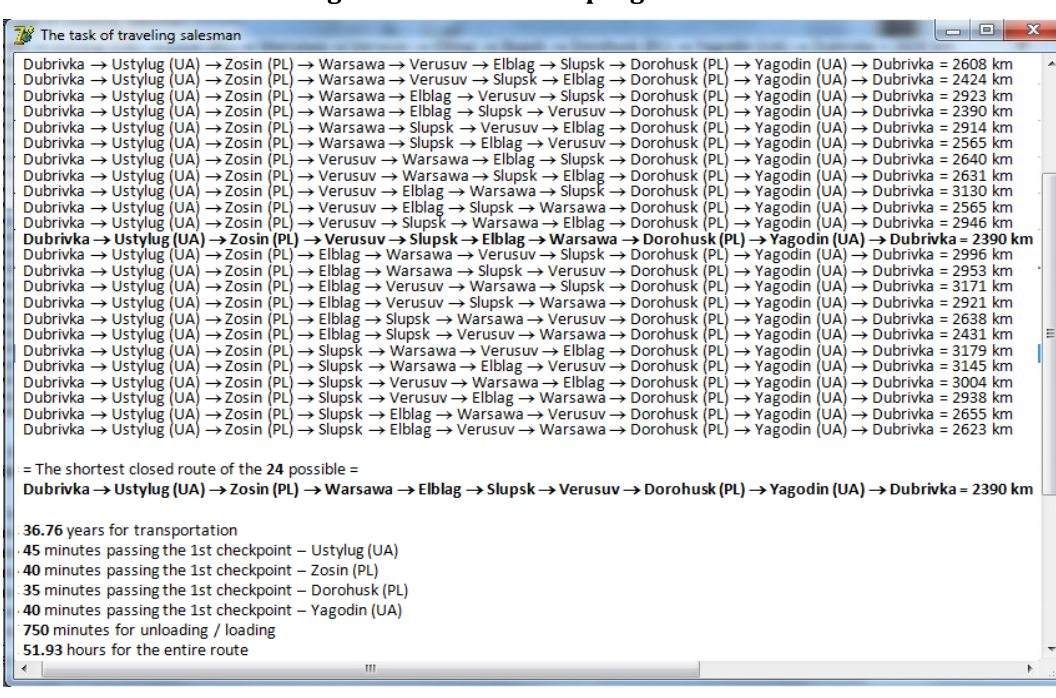
Figure 4: Result of the program work